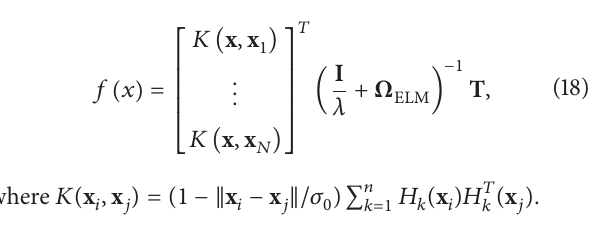
Figure 5: The Triangular Hermite kernel output 𝐾 Tri the 3rd order: 𝑥 ∈ [−0.5, 0.5] and 𝑧 =